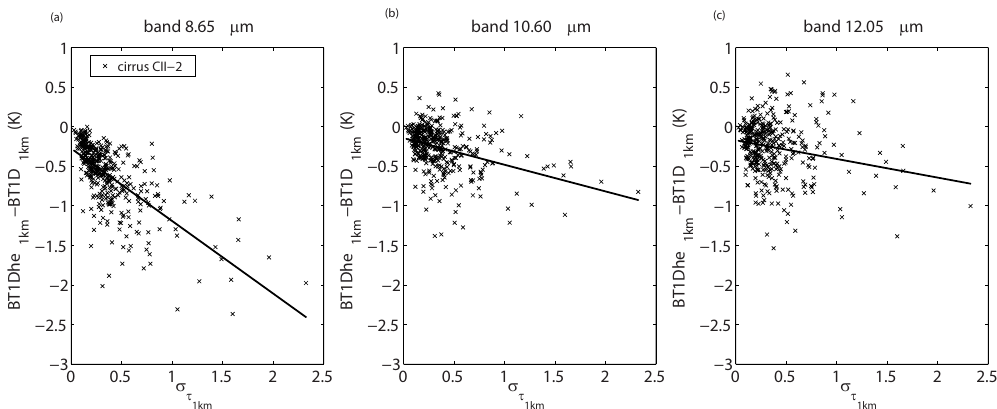
Figure 14. Differences between brightness temperatures viewed at the nadir between a 1-D radiative transfer with vertically heterogeneous columns ( BT1 − Dhe 1km ) and with homogeneous columns ( BT 1 − D 1km ) as a function of the optical thickness standard deviation σ τ cirrus CII-2 and for the bands at 8 . 65µm, 10 . 60µm and 12 .